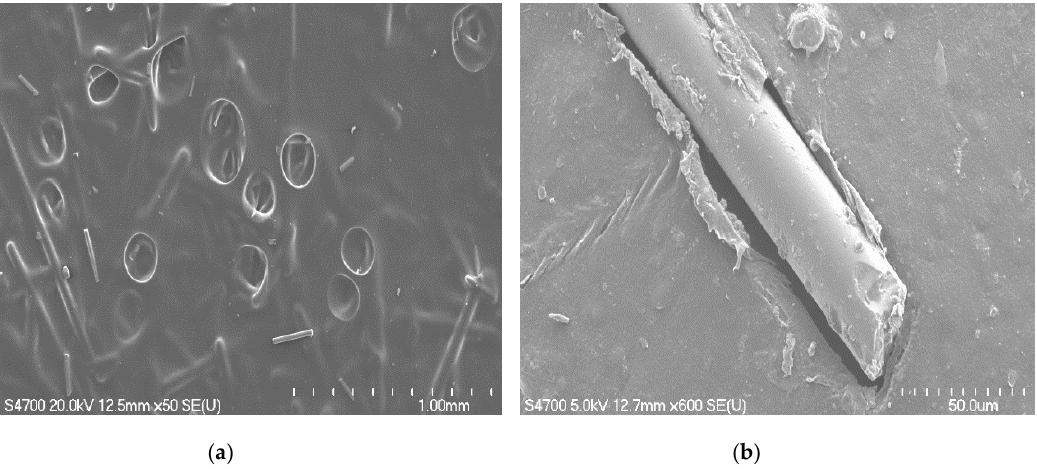
Figure 9. SEM of CEM with untreated glass fiber. ( a ) Low magnification; ( b ) high magnification.